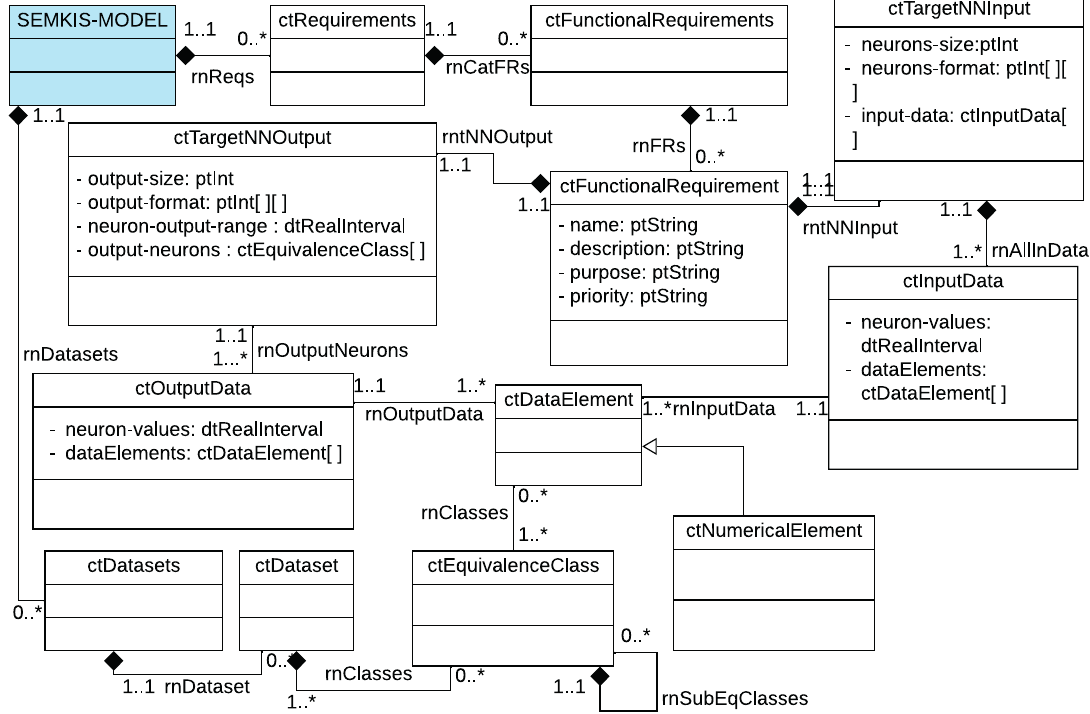
Figure 3. SEMKIS-DSL Metamodel: Functional requirements specification